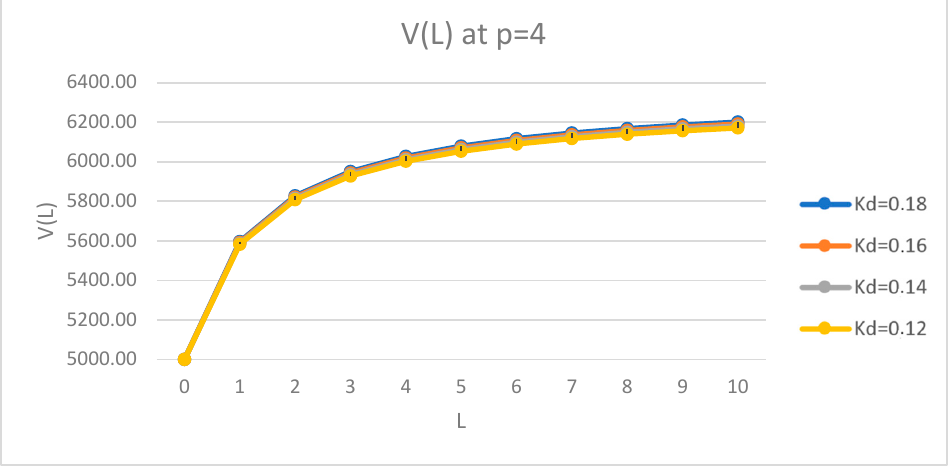
Figure 12. Dependence of the company capitalization, V, on leverage level L at different debt cost k d (12%; 14%; 16%; 18%) and fixed frequency of payments of tax on profit p = 4. Let us show these dependencies in larger scale.